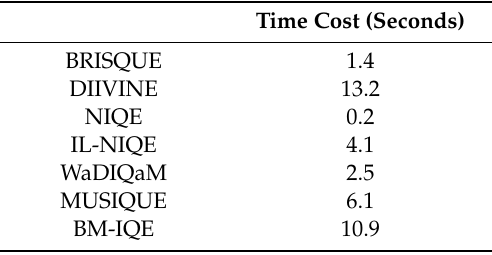
Table 9. Time cost of NR-IQA